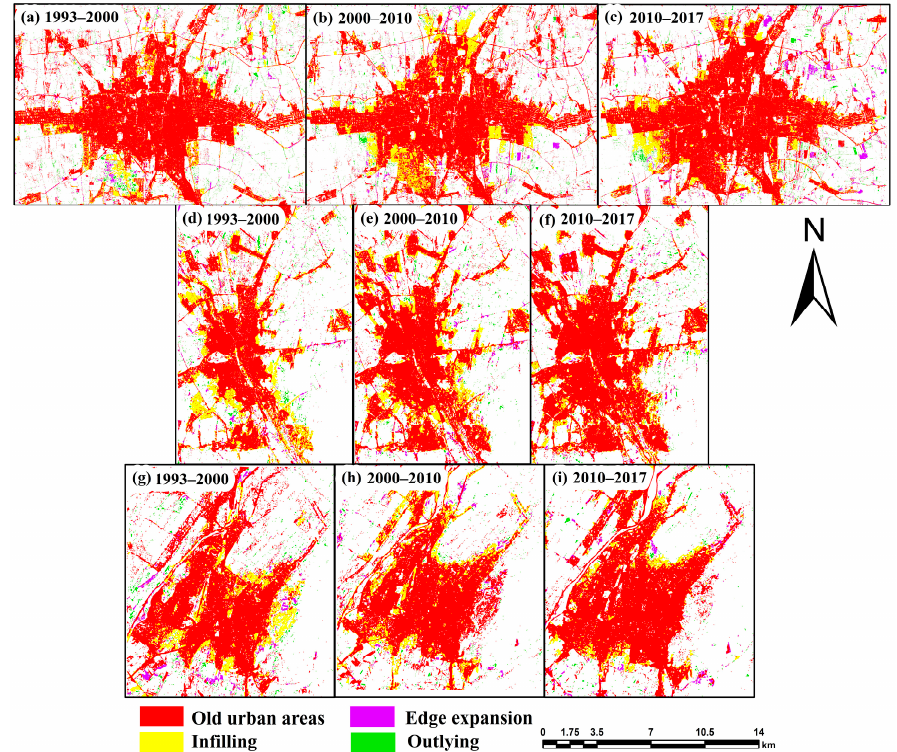
Figure 8. Spatial distribution of urban growth in the three main cities of Kyrgyzstan for the study period for ( a – c ) Bishkek, ( d – f ) Osh, and ( g – i ) Jalal-Abad for three different periods.